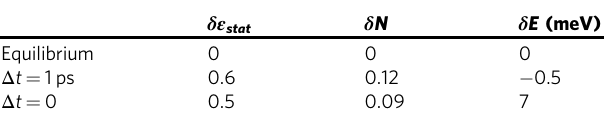
Fig. 3 Differential dispersion and dynamics of the waveguide mode in WSe 2 . These data were collected on a 90 nm slab of WSe 2 with the probe energy E = 1.61 eV and pump energy E = 1.56 eV (Supplementary Notes 5 and 7). a , b were collected with a pump power of 1.5 mW (see Supplementary Note 7 for fl uence dependence). a Values of δ q Δ t . The solid blue line indicates the pump-probe convolution. b Values of 2 (blue dots) are displayed as a function of δ q 1 (red dots) are extracted from the same dataset used in panel a . The solid green line is calculated from an Auger model (see Supplementary Note 9), while the blue line indicates the pump-probe convolution. The red line is the sum of the latter two functions. c , Lorentz model calculations of the dispersion relationship in equilibrium and non-equilibrium conditions (Table 1; Supplementary Note 8). The calculations show the equilibrium dispersion relationship (dashed black line) in the vicinity of the A-exciton, initially at energy E x , (black dashed arrow). A non-equilibrium blueshift of the A-exciton 10 to an energy E ’ = E + 7 meV (blue arrow) produces trend (I) (blue line). Bleaching of the A-exciton (see main text) produces trend (II) (red line). d The differential x x dispersion de fi ned as the trend of δ q 1 = q 1,p − q 1,r vs. ω . The differential dispersion of the blue-shifted A-exciton 10 produces the trend (i) (blue line). The differential dispersion of the bleached A-exciton produces the trend (ii) (red line), see main text. e The experimental differential dispersions were obtained at two-time delays Δ t = 0 (blue dots) and Δ t = 1 ps (red dots) with a pump power of 3 mW. The red and blue lines are calculations using the parameters reported in Table 1. Bleaching of the A-exciton, trend (ii), is prominent in Δ t = 1 ps data (red line), while a blue-shift of the A-exciton, trend (i), plays a dominant role in Δ t = 0 data (blue line). An approximately linear decrease of q 1 ( E ), produced by the decrease of ε * stat , is also included in the calculations at both time delays (black dashed line). Table 1 Parameters of the Lorentz model for the dielectric